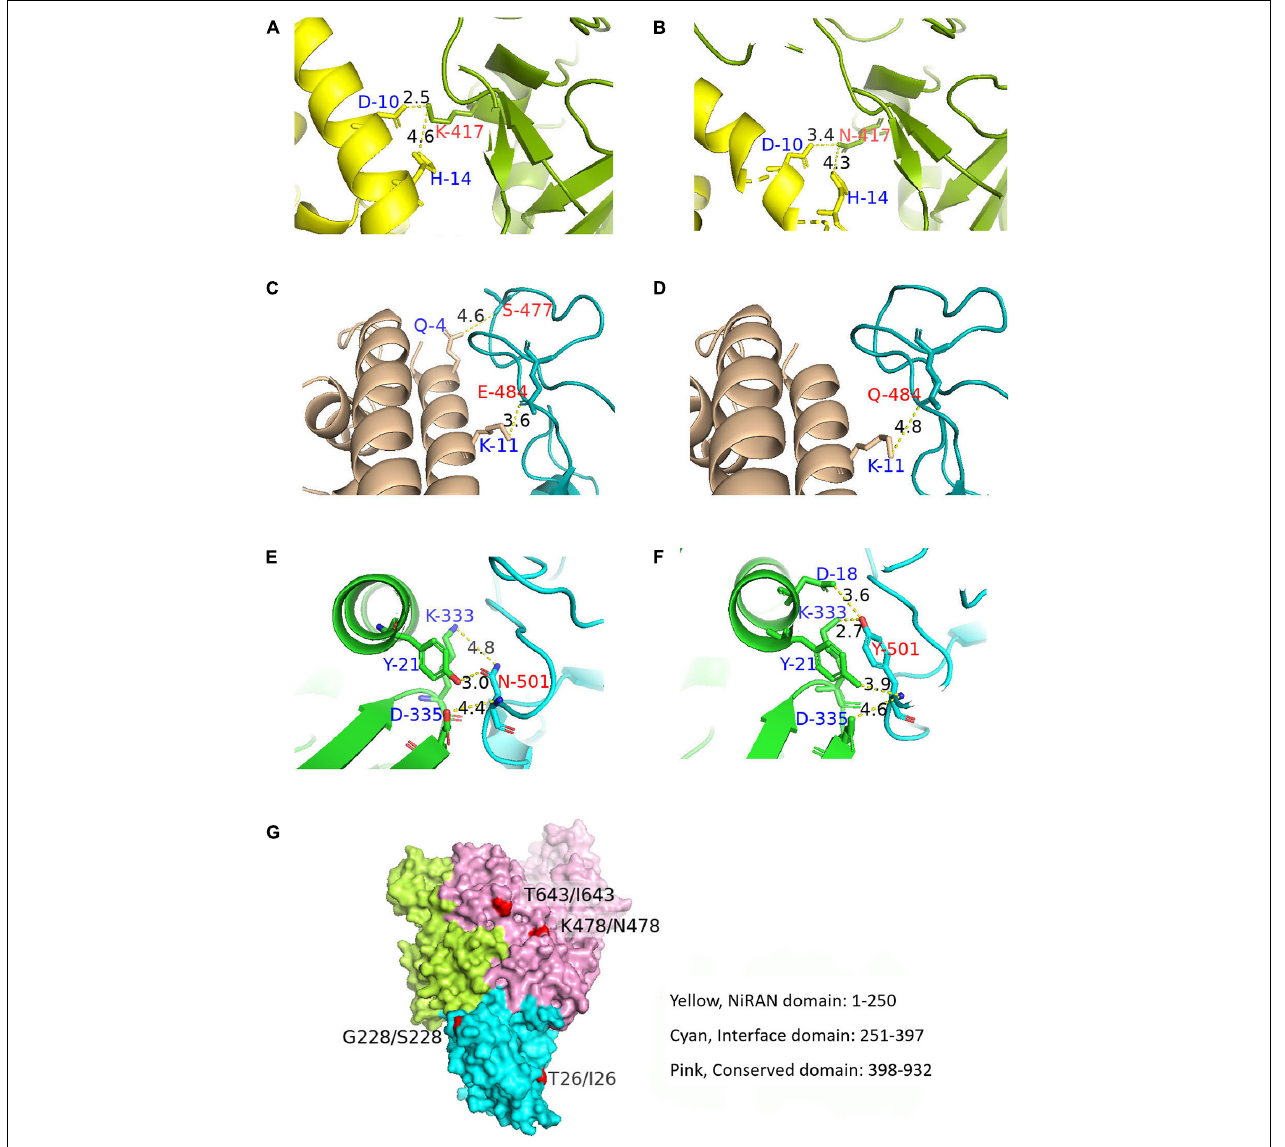
FIGURE 5 | Docking structures showing the interaction between B.1.617 S-RBD and hACE2 and the tertiary B.1.617 RdRp structure. (A,B) Bonding networks of K417 and N417 aa residues showing no significant bonding network change in the two mutants. (C,D) Bonding networks of aa residues E484 and Q484 showing that the E484 mutation enhances the interaction with hACE2, compared with Q484. (E,F) Bonding network of aa residues N501 and Y501 showing that the Y501 mutation considerably enhances the interaction with hACE2, compared with N501. (G) RdRp spatial structure. The aa substitutions in RdRp did not cause spatial structural changes. Red: aa substitution sites on the protein surface. S-RBD, receptor-binding domain of the S protein; hACE2, human angiotensin-converting enzyme; RdRp, RNA-dependent RNA